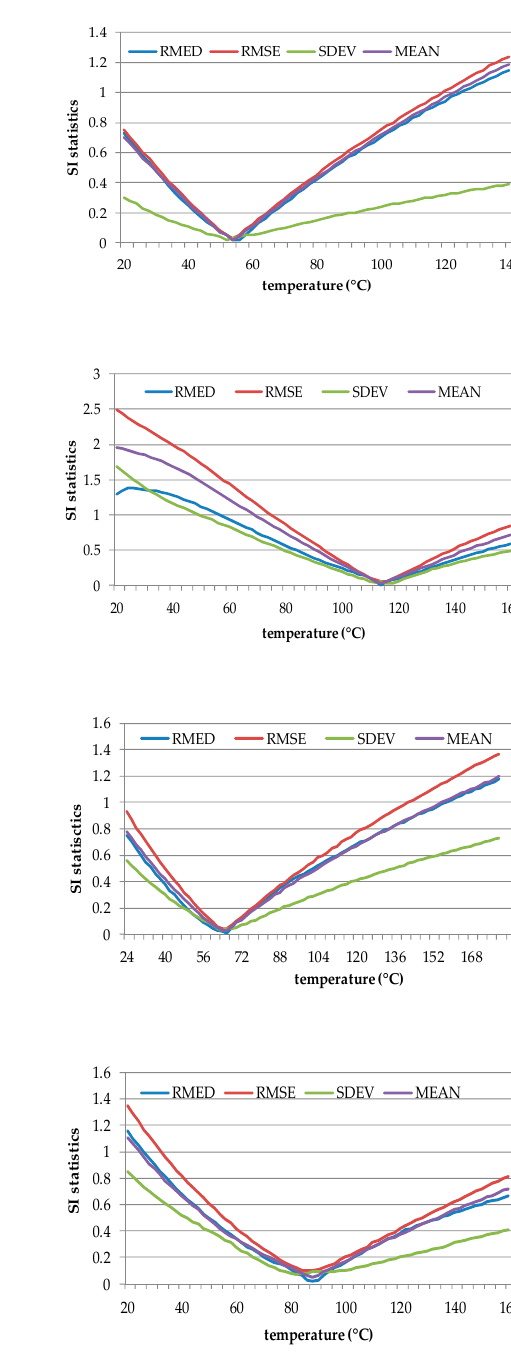
Figure 6. Changes in the saturation indices (SI) and SI statistics: median (RMED), mean (MEAN), standard deviation (SDEV) and mean root square error (RMSE) of absolute log(Q/K) values as a function of model reservoir temperature; ( a )—C-1, ( b )—KT-1, ( c )—ST-1, ( d )—GT-1, ( e )—L-2, ( f )—LZT-1.